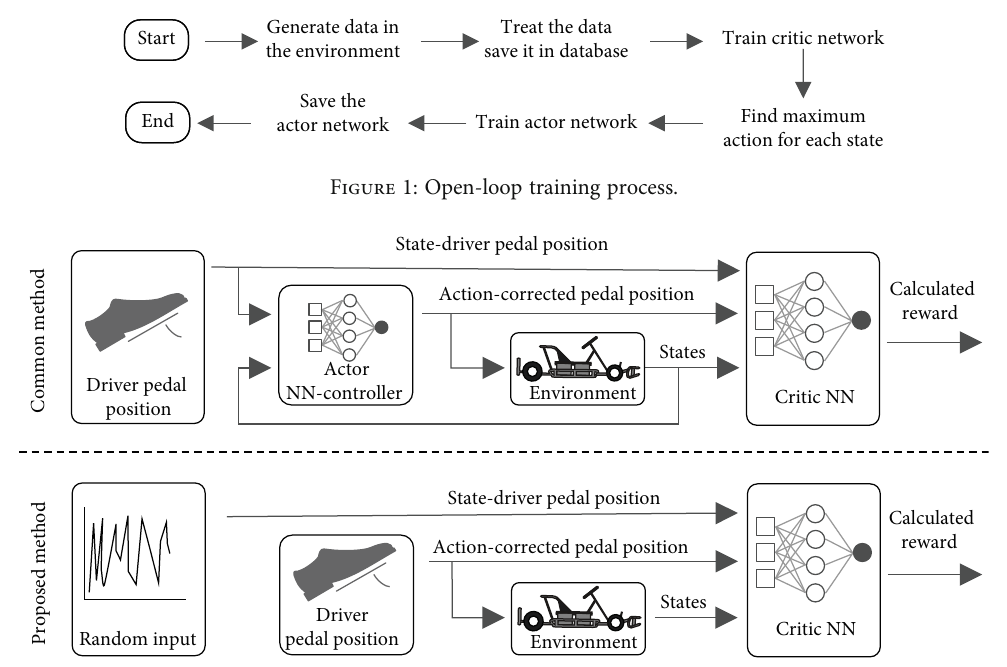
Figure 2: Correlation between environment and input